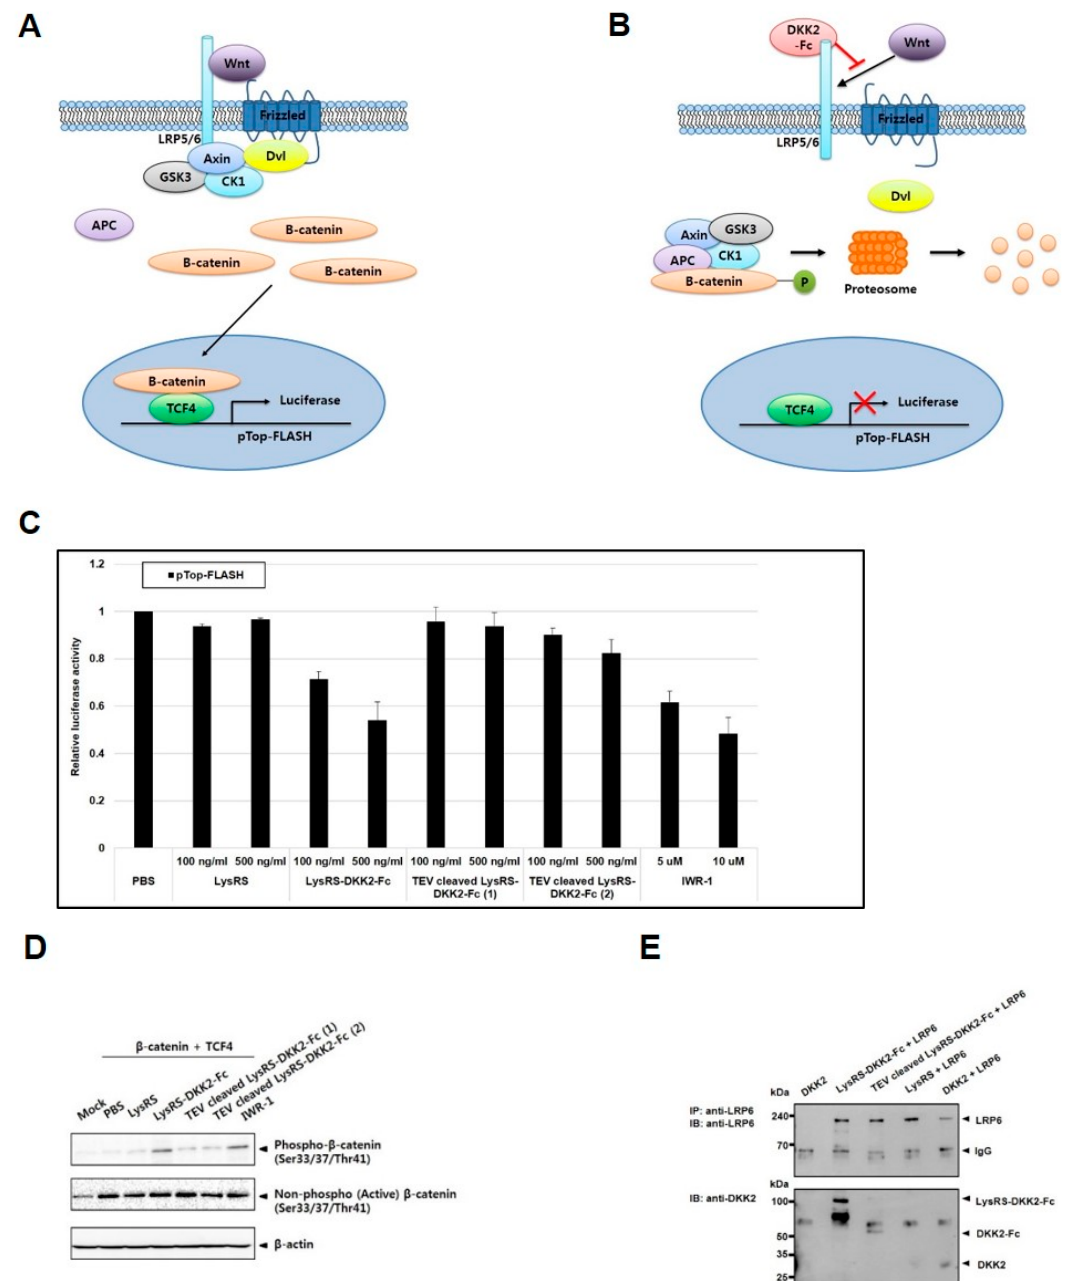
Figure 4. Inhibitory e ff ect of recombinant DKK2-Fc on the Wnt signaling pathway. ( A ) Schematic diagram of the Wnt / β -catenin signaling pathway. ( B ) Schematic diagram of luciferase reporter gene transcription inhibition in the presence of recombinant DKK2-Fc. TOPflash reporter was co-transfected into HEK 293T cells with β -catenin and TCF4 plasmids. ( C ) TOPflash luciferase activity assay. HEK 293T cells were treated with PBS, recombinant protein (LysRS, LysRS-DKK2-Fc, TEV-cleaved LysRS-DKK2-Fc (1), TEV-cleaved LysRS-DKK2-Fc (2)), or IWR-1 as a positive control at two di ff erent concentrations. The bars indicate the relative TOPflash luciferase activity compared to that of PBS. The error bars indicate the mean ± SD of three experiments. ( D ) The e ff ect of DKK2-Fc on phosphorylation of β -catenin in HEK 293T cells. HEK 293T cells were transfected with β -catenin and TCF4 plasmids, and were treated with PBS, recombinant protein (LysRS, LysRS-DKK2-Fc, TEV-cleaved LysRS-DKK2-Fc (1), TEV-cleaved LysRS-DKK2-Fc (2)), or IWR-1. Treated cells were collected, lysed, and subjected to western blotting using the indicated antibodies. ( E ) Co-immunoprecipitation of DKK2-Fc and LRP6. Each protein was immunoprecipitated with anti-LRP6 antibody and detected by anti-LRP6 or anti-DKK2 antibody. 2.4. Recombinant DKK2-Fc Induces Tube Formation in an In Vitro Model of Angiogenesis DKK2 is known to induce EC morphogenesis and stimulate angiogenic sprouting [13]. We tested the biological function of LysRS-DKK2-Fc and TEV-cleaved LysRS-DKK2-Fc in vitro with a tube formation assay in HUVECs. When Matrigel-containing media was added to a monolayer of HUVECs, the attached ECs formed branched tubes. HUVEC monolayers treated with 50 or 100 ng/mL recombinant LysRS-DKK2-Fc and TEV-cleaved LysRS-DKK2-Fc for 16 h resulted in significant enhancement of EC tube-like structures (Figure 5A,B). Recombinant DKK2-Fc was shown to have 65–75% activity compared with basic fibroblast growth factor (bFGF) and VEGF, which are potent angiogenic factors. Negative controls vehicle and LysRS had no detectable angiogenic activity (Figure 5A,B). These results indicate that DKK2-Fc had a biologically active conformation and significant functional activity during angiogenesis in vitro.